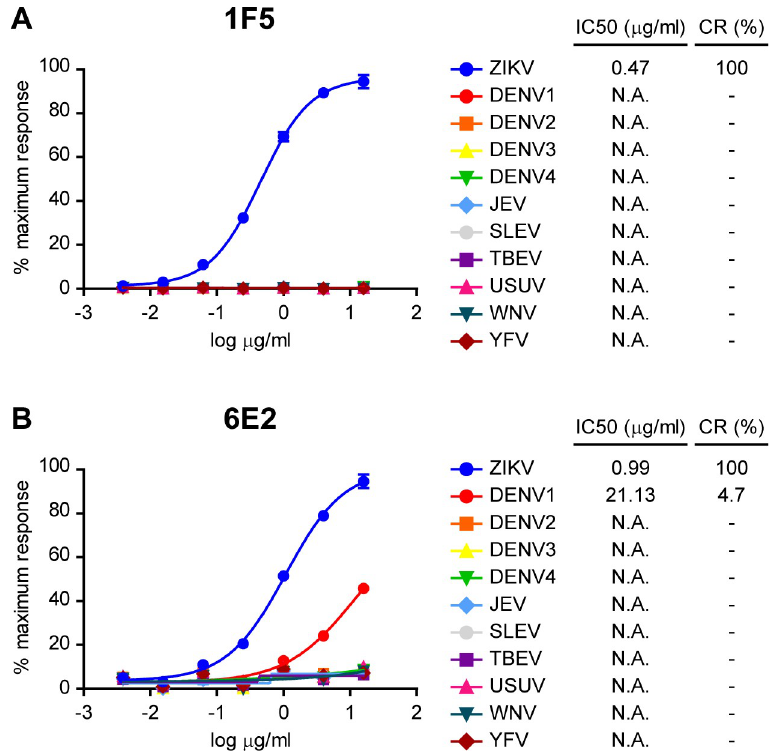
Fig 3. Comparative reactivity of flavivirus recombinant NS1 proteins by indirect ELISA with 1F5 and 6E2 mAbs. Standard curves of denatured E . coli -expressed DENV1-4, JEV, SLEV, TBEV, USUV, WNV, YFV and ZIKV recombinant NS1 proteins by iELISA with (A) 1F5 or (B) 6E2 mAbs. Each point of the curve represents mean ± SEM of three sample replicates. IC50 and CR values of the mAbs are indicated. N.A.: not applicable.